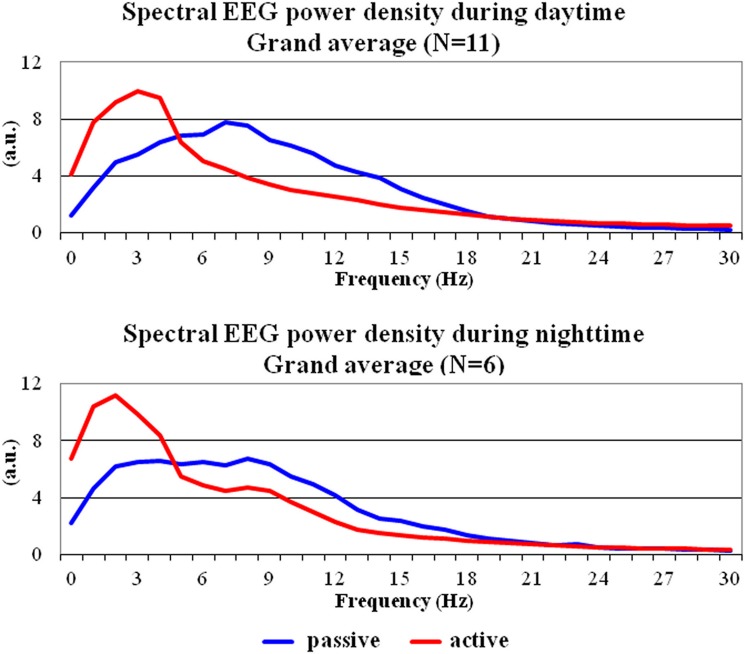
Grand-average across gray mouse lemurs of the normalized electroencephalographic (EEG) power density spectra between 0 and 30 Hz relative to the active and passive behavioral states.These spectra refer to the daytime (N = 11) and nighttime (N = 6) periods of interest. Lemurs having an insufficient amount of artefact-free EEG epochs in the passive state for the final analysis were not considered (daytime: L#4 and L#10; nighttime: L#1, L#2, L#3, L#4, L#11, L#12, and L#13).